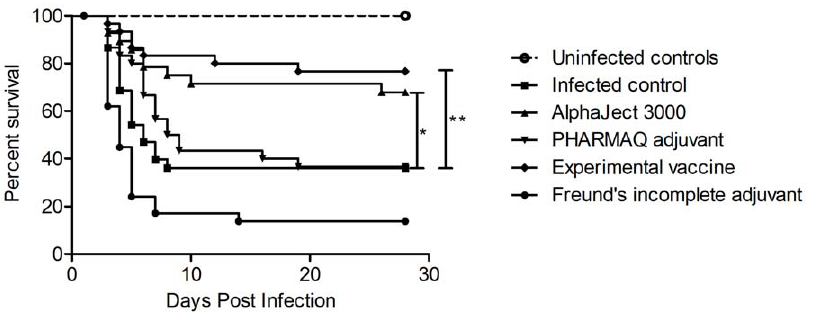
Figure 1. Survival curves from bacterial challenge. Survival curves representing the outcome of the bacterial challenge. N=30 for each group, except AlphaJect 3000 (N=28). The two vaccinated groups showed significantly higher survival than infected controls (P=0.001 and 0.01 for experimental vaccine and AlphaJect 3000, respectively), as well as their respective adjuvants (P=0.0001 and 0.02 for experimental vaccine and AlphaJect 3000, respectively). Asterisks indicate statistically significant difference between treated group and infected controls (*=P , 0.05, **=P , 0.01).